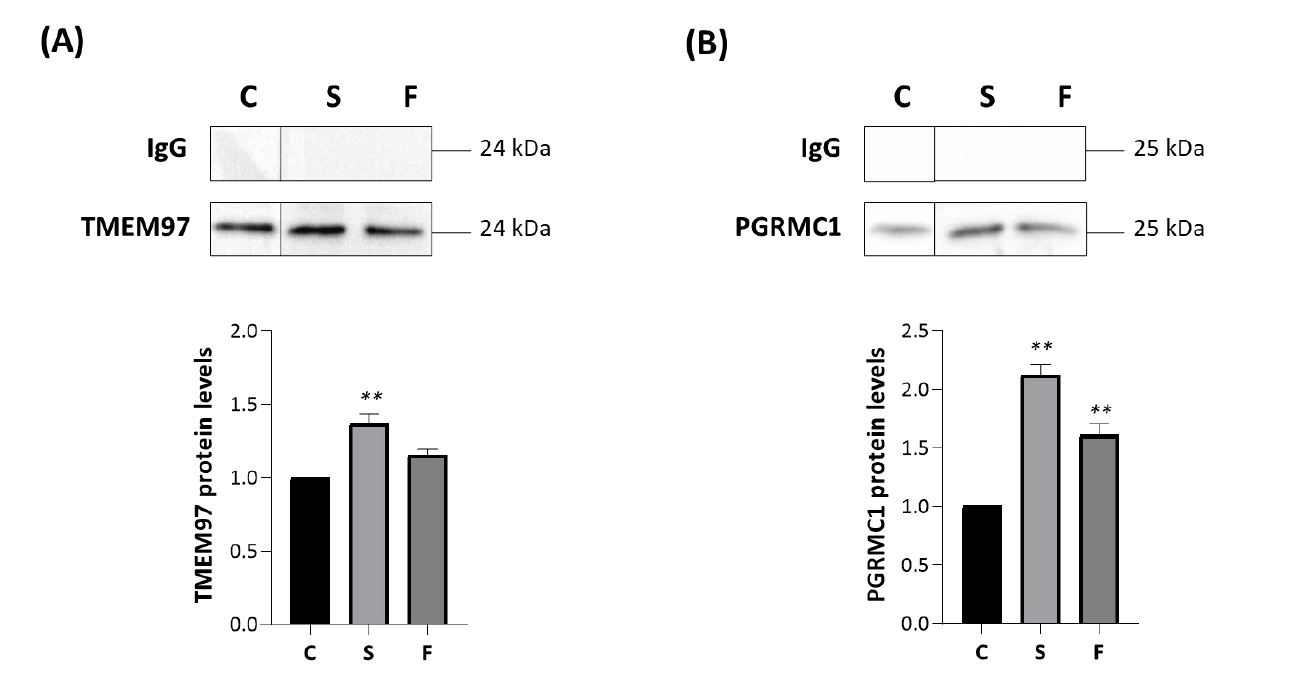
Figure 6. Siramesine oxalate salt and FA10 hydrochloric salt affect the associations TSPO-TMEM97 and TSPO-PGRMC1. MP cells were treated for 2 h with siramesine oxalate salt (S) and FA10 hydrochloric salt (F), immunoprecipitated with an antibody directed against TSPO and analyzed by Western blot with anti-TMEM97 ( A ) or anti-PGRMC1 ( B ) specific antibodies. IgG is the negative control for the TSPO antibody. Western blotting graphs depict the results of at least three independent experiments. TMEM97 and PGRMC1 protein levels in treated cells were normalized versus proteins in untreated cells (C) and reported in the respective graph bars (lower panels) as means ± SD (error bars). Statistical significance of the differences was evaluated by using one-way ANOVA followed by Dunnett’s multiple comparisons test (** p < 0.01).